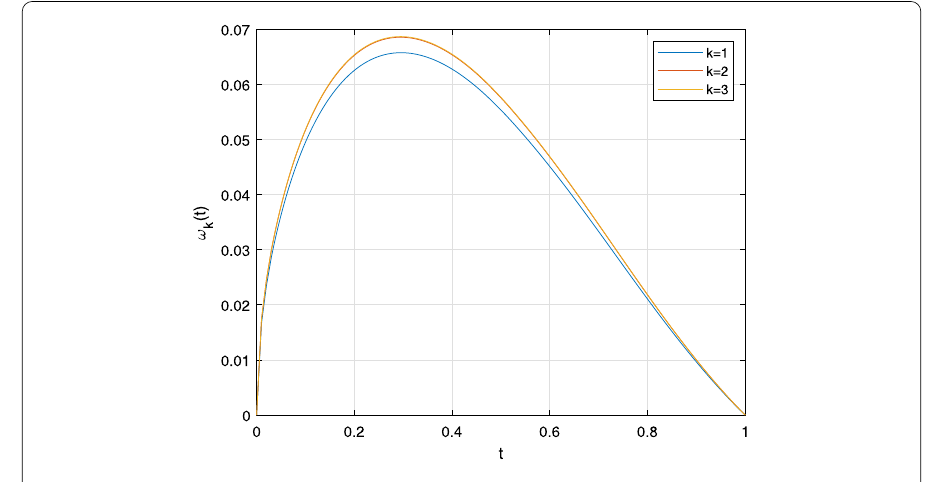
Figure 1 Graphs of the successive approximation of